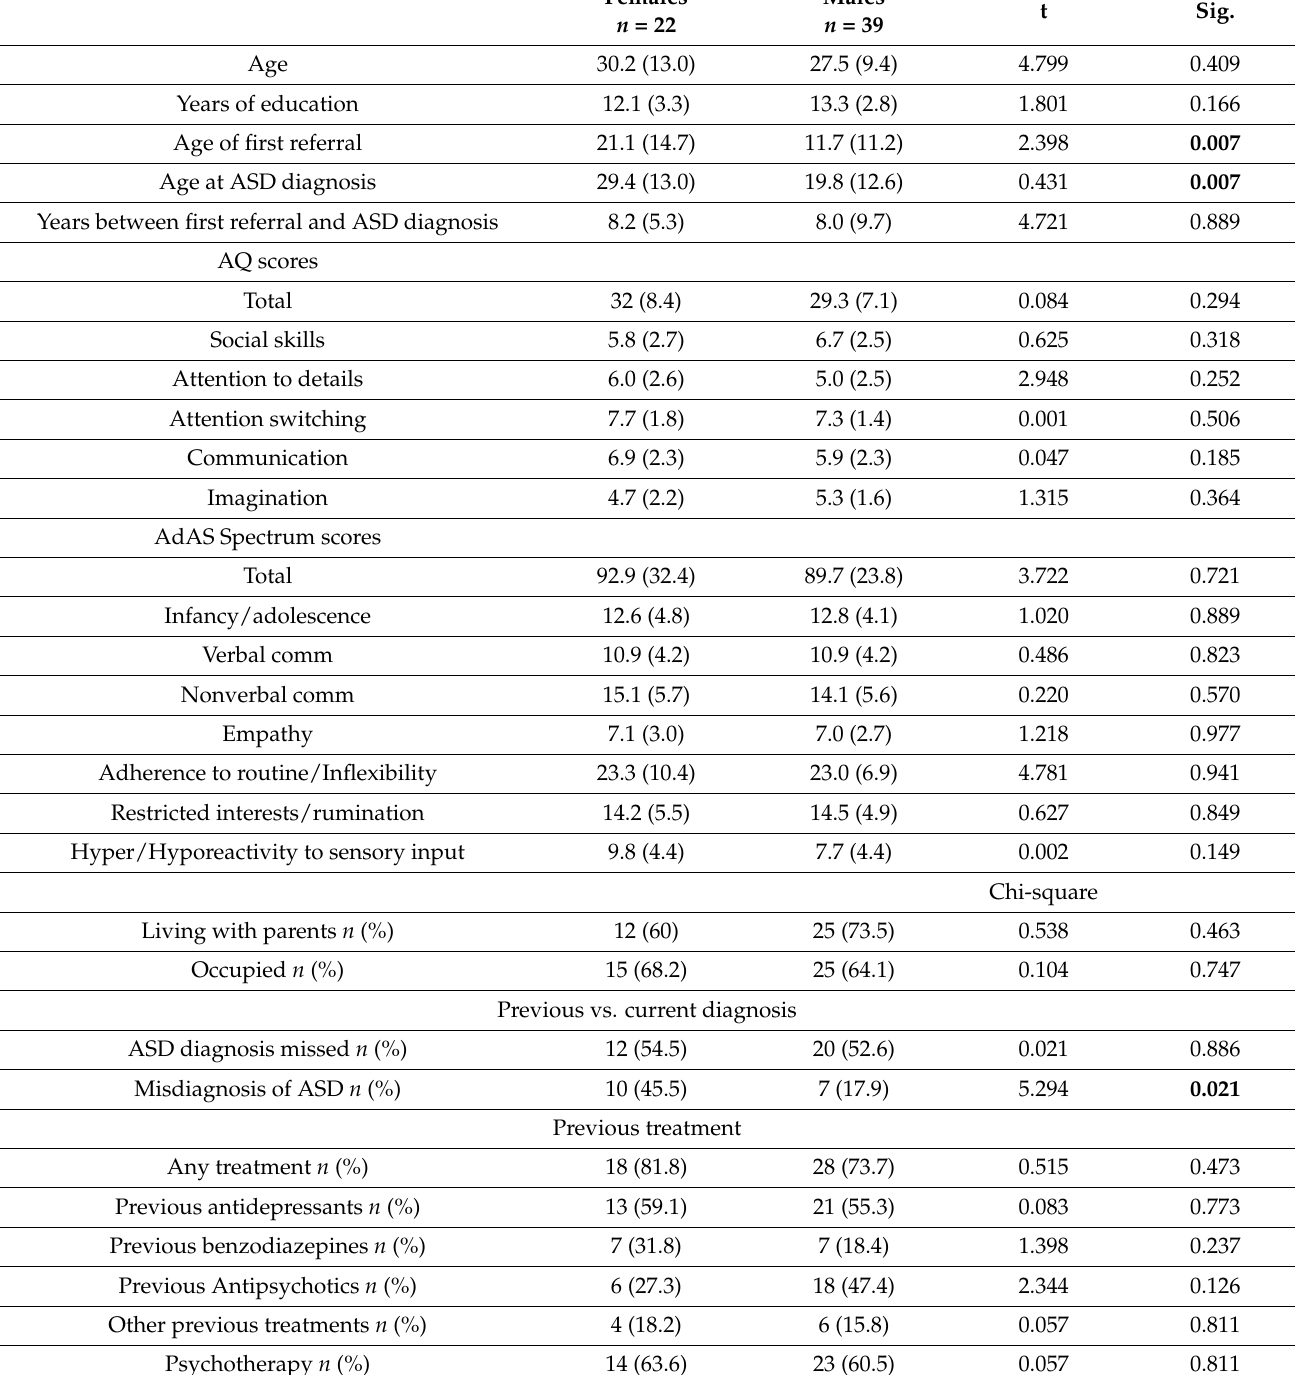
Table 1. Socio-demographic and clinical characteristics of the study